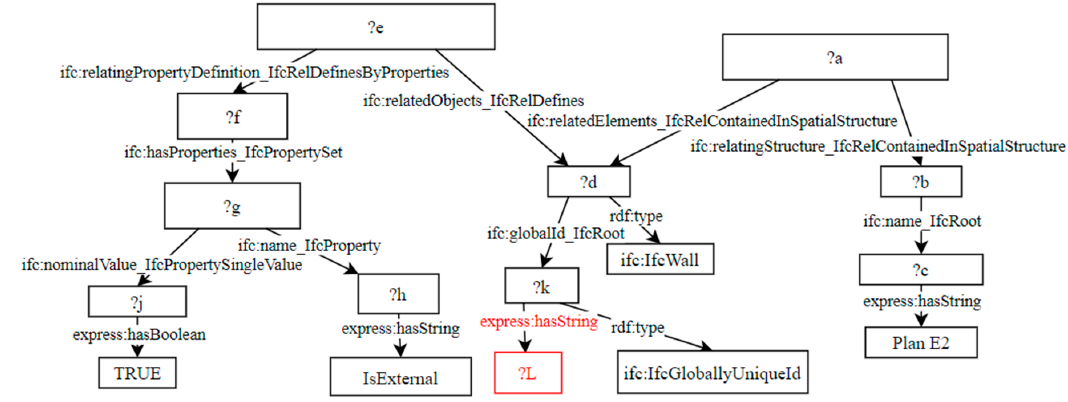
Figure 13. The structure of the shortest path with query variables in this case.